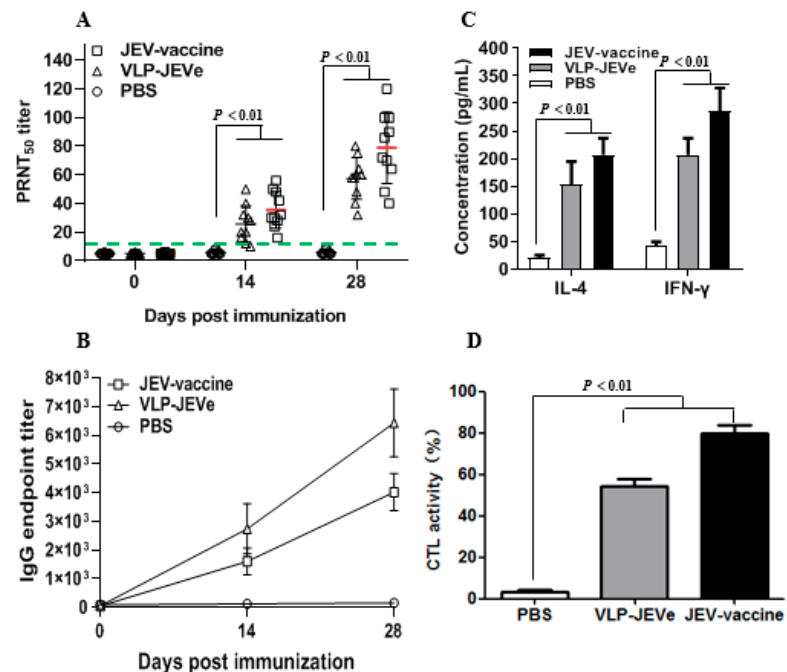
Figure 3. Antibody response in mice. ( A , B ), Three groups of mice BALB/c mice were immunized with purified VLP-JEVe, live-attenuated SA 14 -14-2 vaccine and PBS. Serum samples were collected at various time-points, and neutralizing antibody titers or ELISA titers against JEV were determined by PRNT 50 . ( C ), Cytokine detection in splenocyte culture supernatants from vaccinated mice. Lymphocytes isolated from the spleens of vaccinated mice at 42 days were stimulated with VLP-JEVe. After 72 h, the supernatants were collected to detect the concentration of Th2-type cytokine IL-4 and Th1-type cytokine IFN- γ by cytokine ELISA kit. ( D ), CTL activity of splenocyte from vaccinated mice two weeks after the last immunization. Splenocytes from the vaccinated mice were stimulated with VLP-JEVe. After 6 days, the CTL activities were determined using a cytotoxicity assay kit by the measurement of the LDH released. All the experiments were performed in triplicate, with the mean ± standard error (SE) shown. p < 0.01 value was compared with groups vaccinated with PBS or VLP-JEVe and SA 14 -14-2 vaccine.